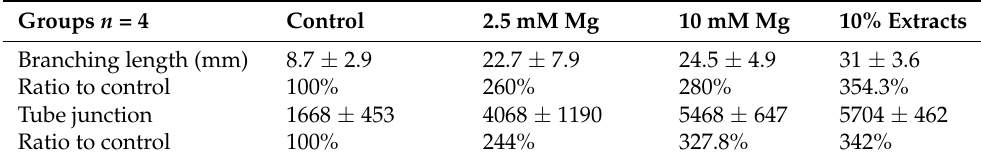
Figure 5. In vitro angiogenesis induction cultured with control medium, 2.5 mM Mg 2+ , 5 mM Mg 2+ , 10 mM Mg 2+ , scale bar: 10 um, n = 4, one-way AONVA, Tukey test, * p < 0.05, ** p < 0.01, *** p < 0.001. Table 2. Tube